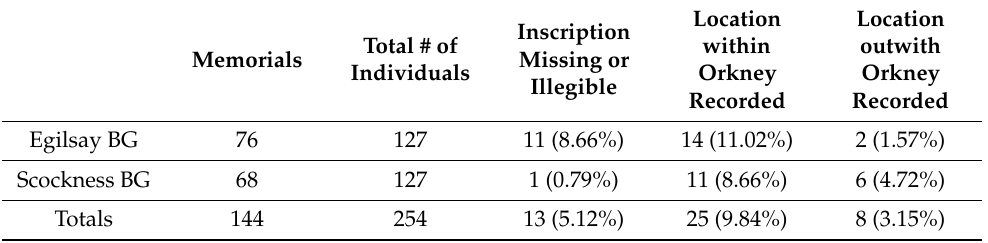
Table 1. Summary of the location information provided by the memorial